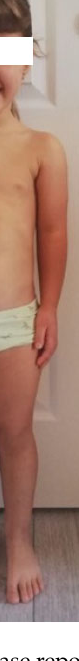
Figure 4. Case report 4: a five-year-old girl with low normal birth weight, height − 1.6 SD, BMI 29th percentile, tested positive for SHOX deletion due to her family history. She is too young to evaluate a mesomelic